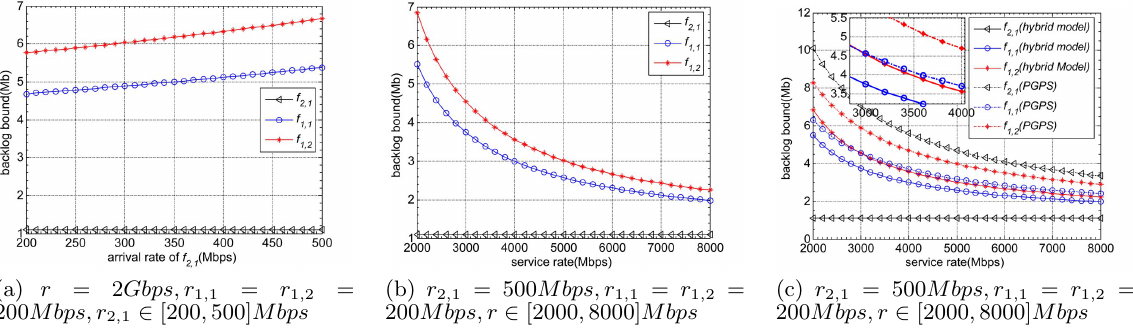
Figure 5: Backlog upper bounds in the single-hop